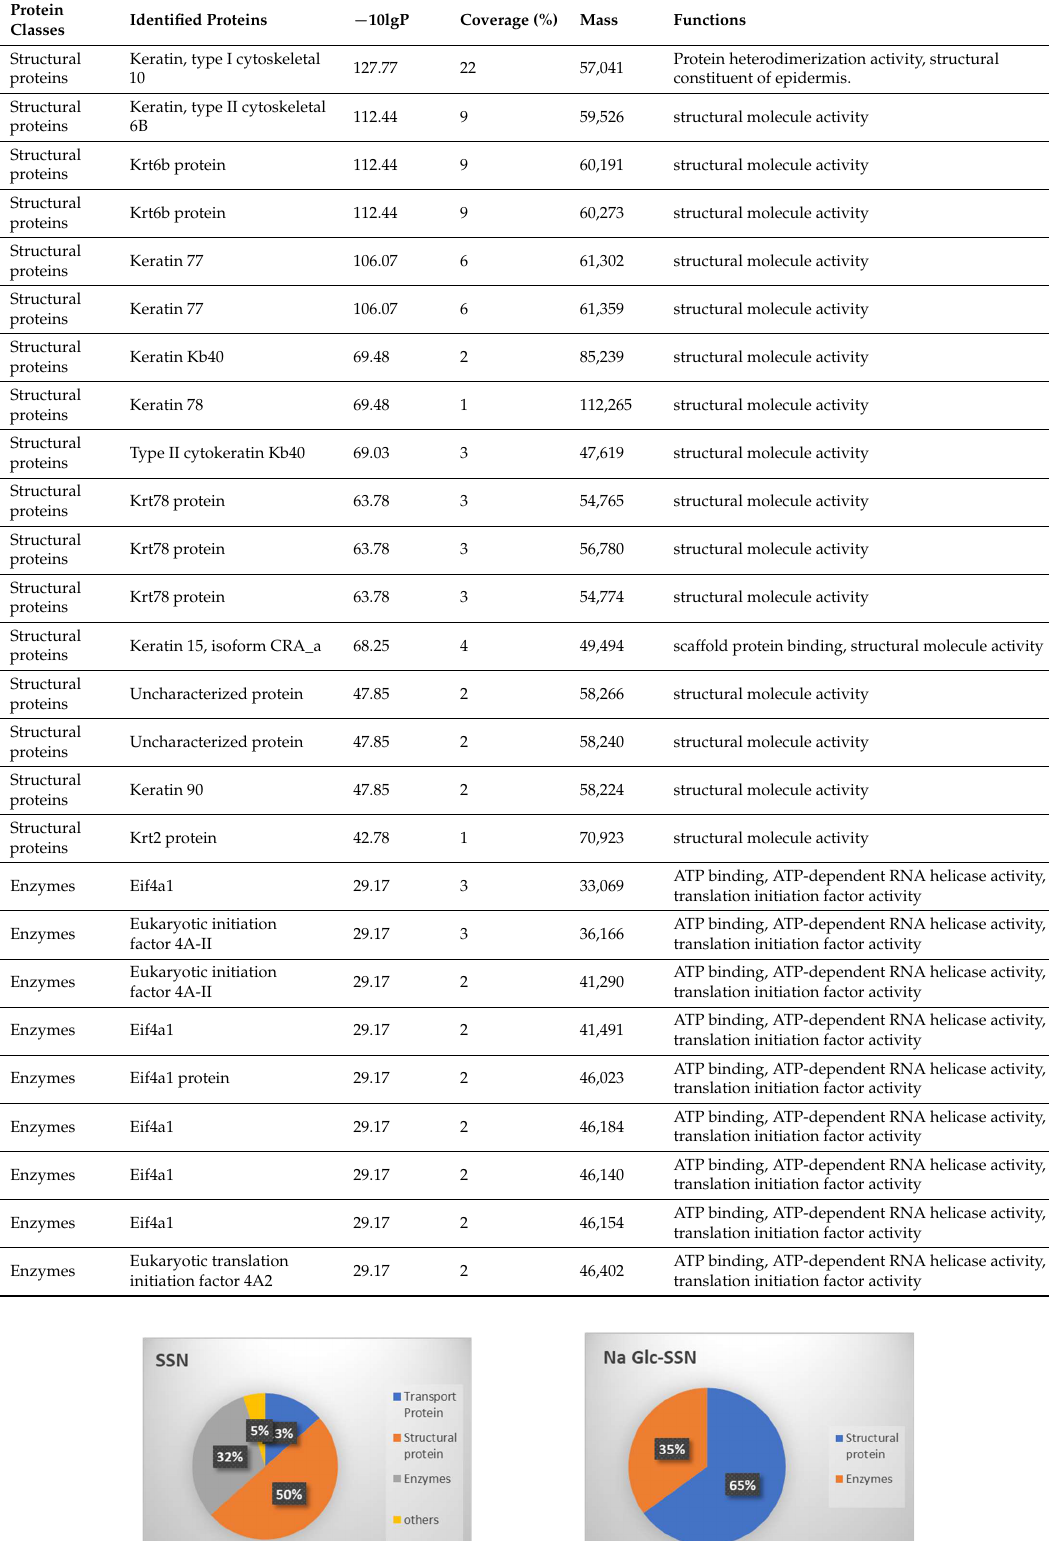
Table 2. Proteins bound with Na-Glc-SSNs in the presence of 10% of mice plasma.